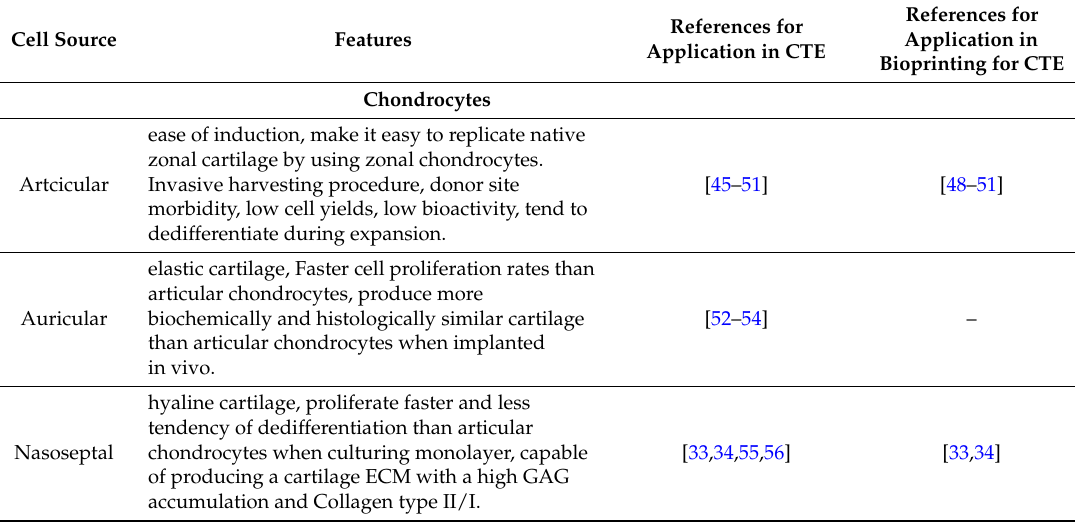
Table 1. Cell sources that have been used in cartilage tissue engineering (CTE) or cartilage